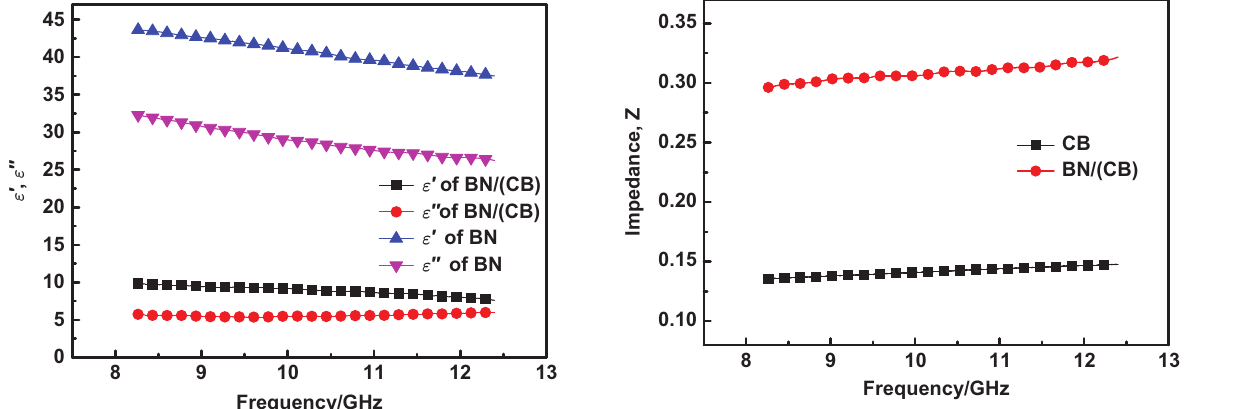
Figure 5: The permittivity ( ε ʹ ε ʹʹ ) of the CB and BN/(CB).